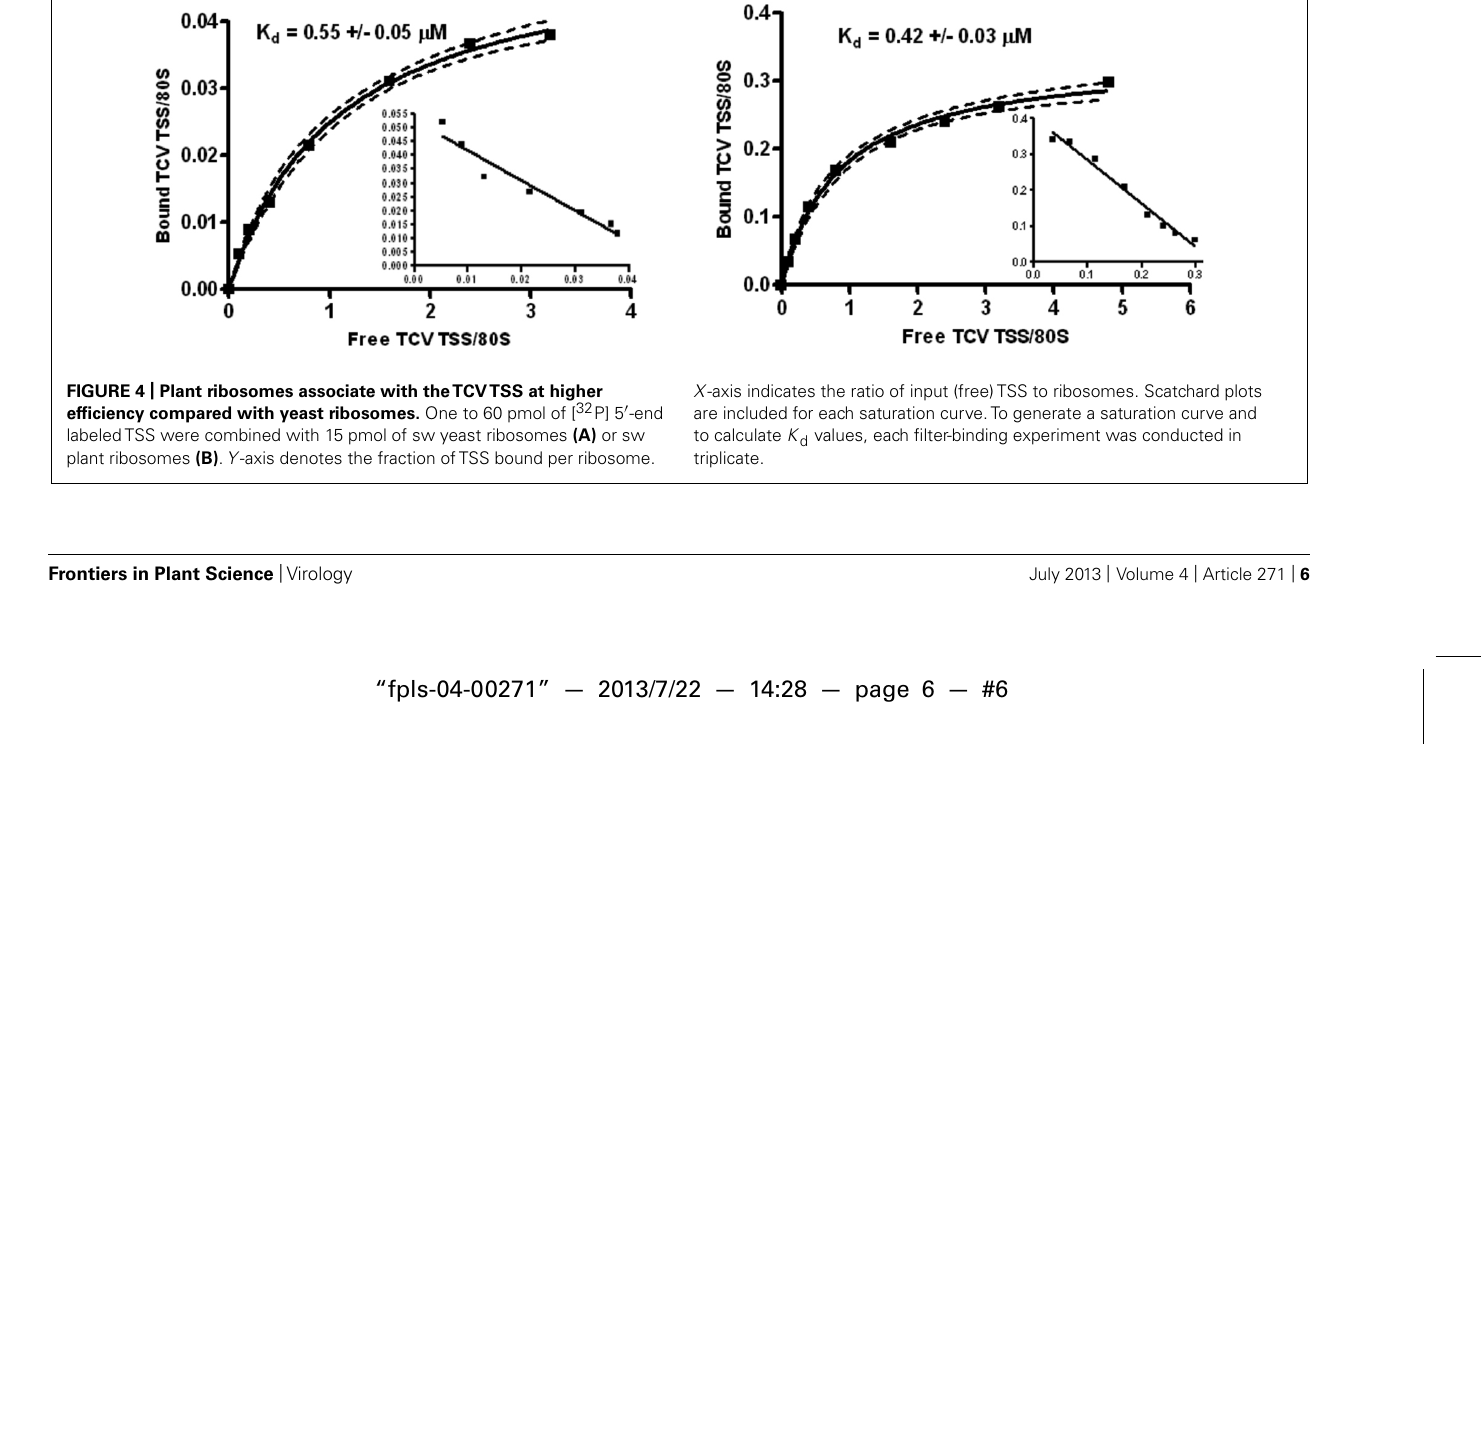
FIGURE 4 | Plant ribosomes associate with theTCVTSS at higher efficiency compared with yeast ribosomes. One to 60 pmol of [ 32 P] 5 (cid:2) -end labeledTSS were combined with 15 pmol of sw yeast ribosomes (A) or sw plant ribosomes (B) . Y -axis denotes the fraction ofTSS bound per ribosome.